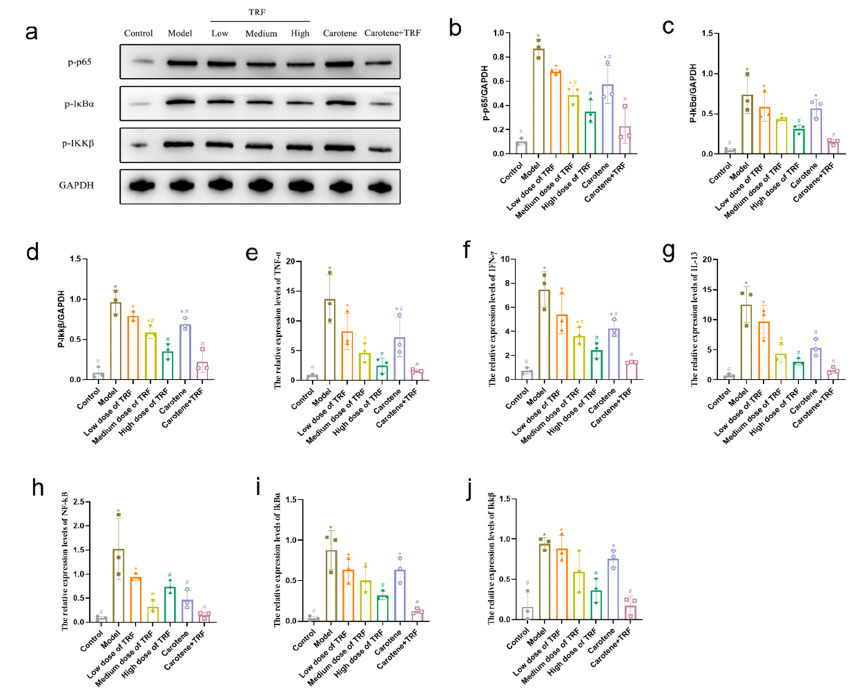
Figure 8. TRF and carotene protected against pulmonary fibrosis via the inhibition of the NF- κ B signaling pathway: ( a – d ) TRF and carotene decreased the expression of fibrosis proteins induced by BLM in SD rats. The protein expressions of ( b ) p-p65, ( c ) p-IkB α , and ( d ) Ikk β in lung samples were examined by Western blotting analysis, n = 3; ( e – j ) representative statistical analyses of ( e ) TNF- α , ( f ) IFN- γ , ( g ) IL-13, ( h ) NF- κ B, ( i ) IkB α , and ( j ) Ikk β mRNA by RT-qPCR, n = 3. Note: compared with CON group, # represents p < 0.05; compared with MOD group, * represents p < 0.05.